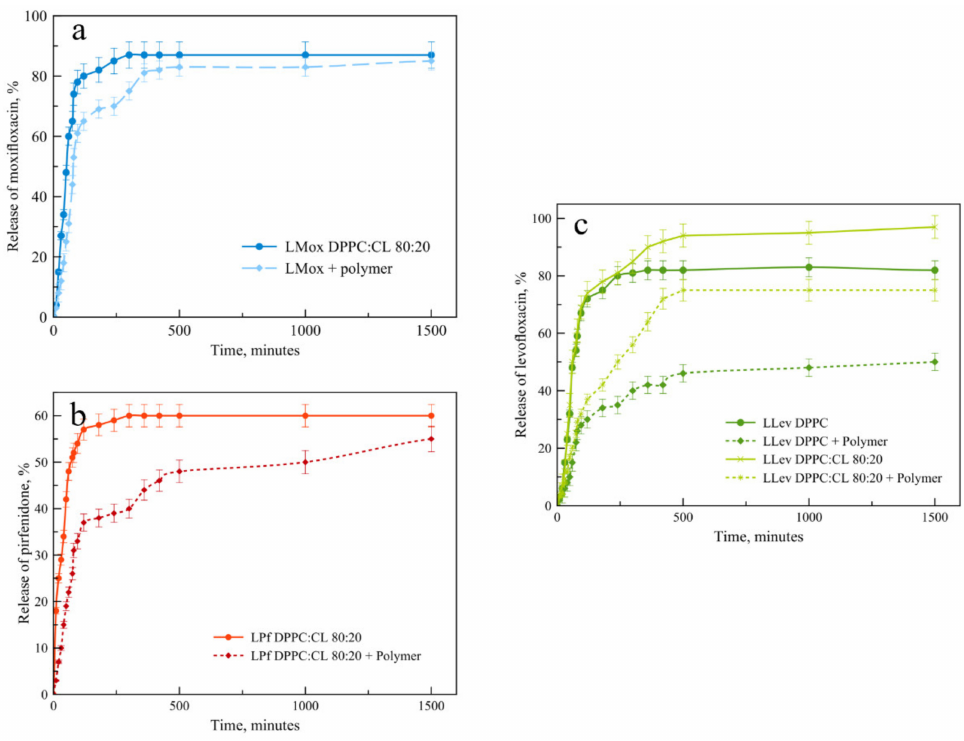
Figure 8. Drug release from liposomal forms of drugs with and without a polymer shell. ( a ) LMox DPPC:CL 80:20 and its complex with mannosylated chitosan, base–molar ratio 1:7. ( b ) LPf DPPC:CL 80:20 and its complex with mannosylated chitosan, base–molar ratio 1:7. ( c ) LLev DPPC and its complex with mannosylated chitosan, base–molar ratio 1:7 and LLev DPPC:CL 80:20 at the same conditions. Total lipid concentration 3 mg/mL in 0.02 M Na phosphate-buffered solution, pH 7.4. 37 ◦ C. SD ( n = 3), p <